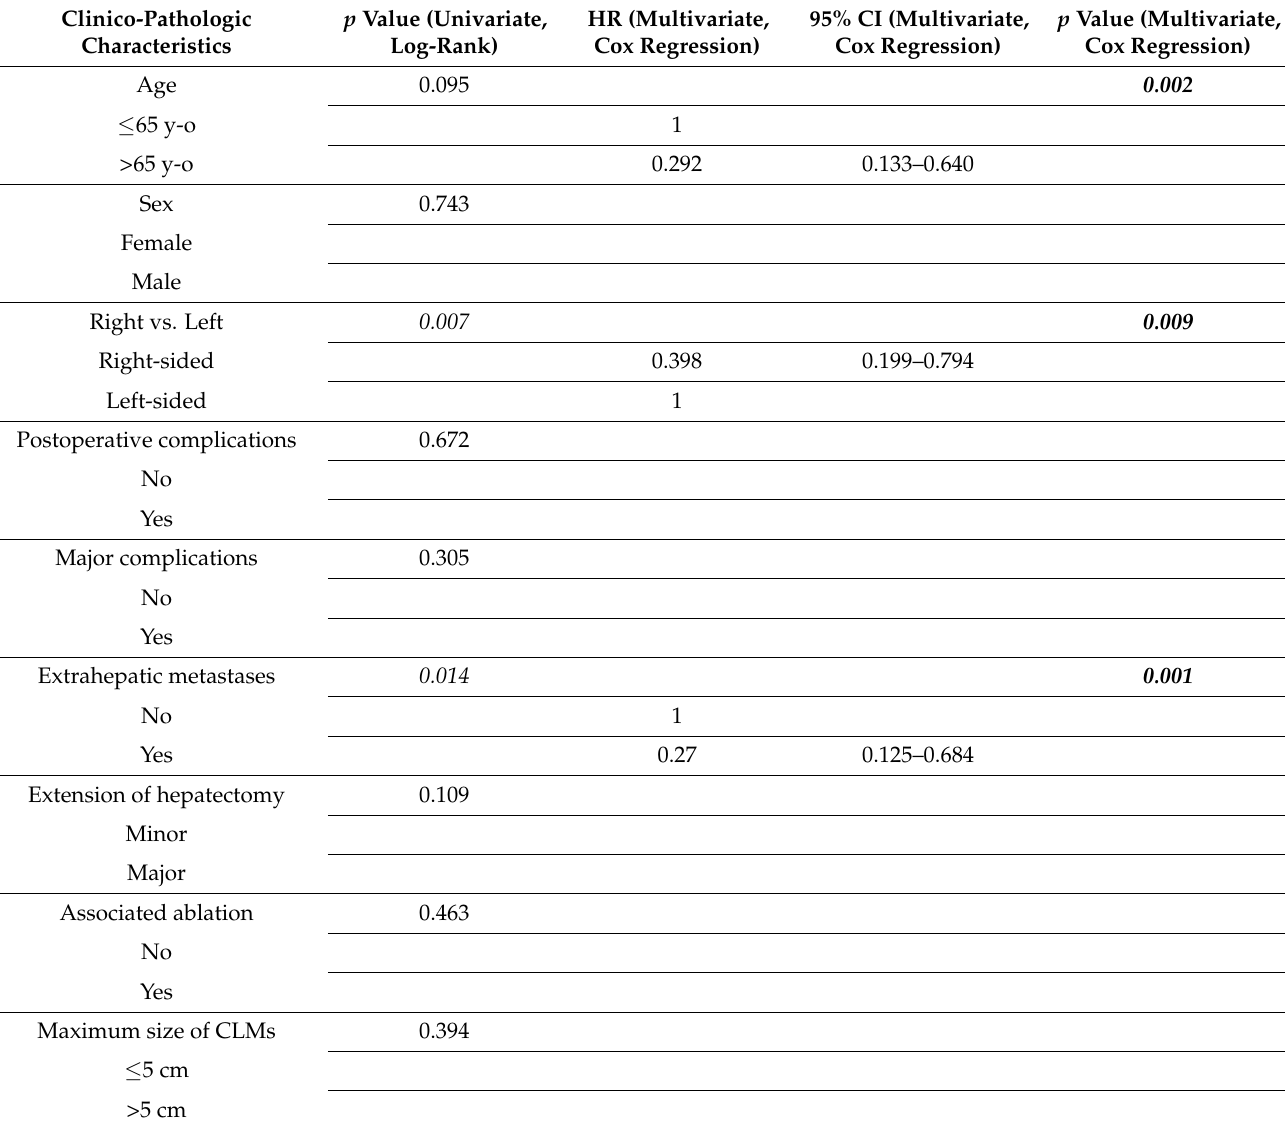
Table 2. Univariate and multivariate analysis for OS in RAS-wt